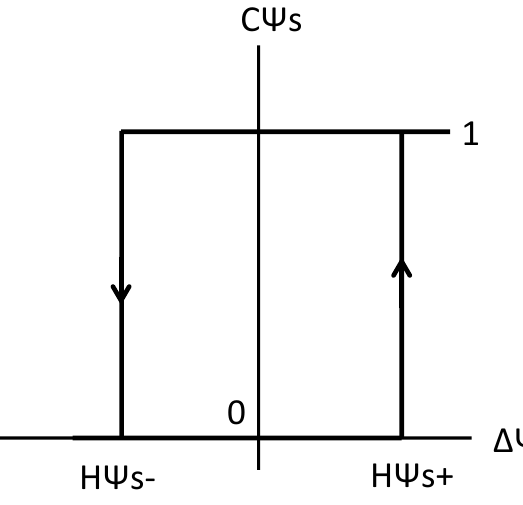
Figure 5. Two-level hysteresis